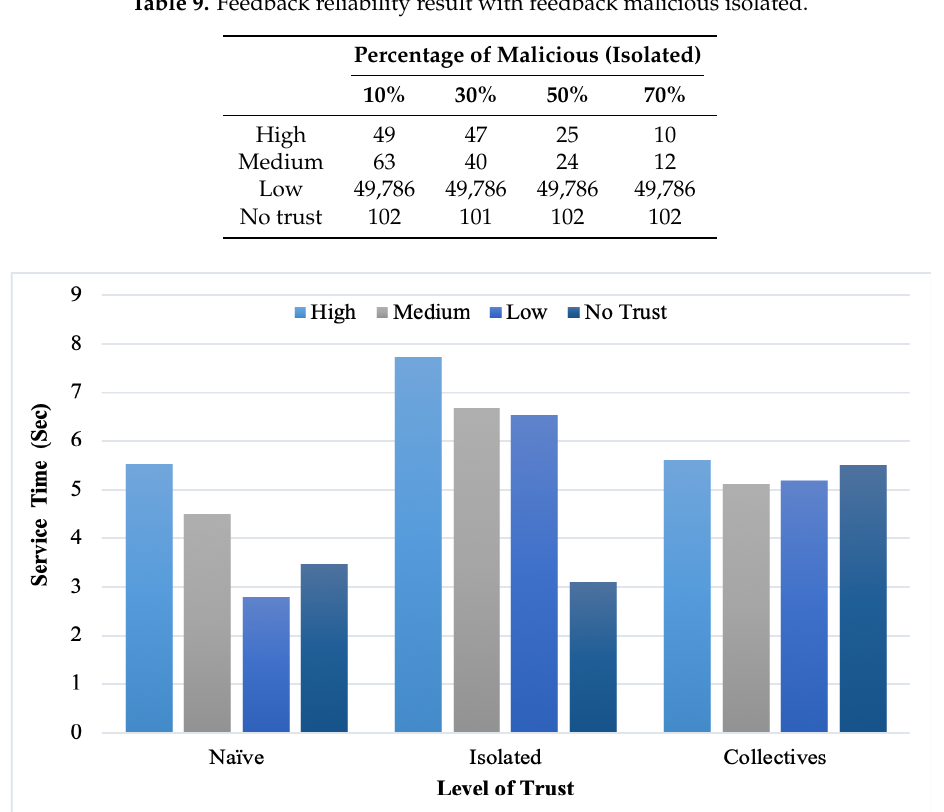
Table 9. Feedback reliability result with feedback malicious isolated.